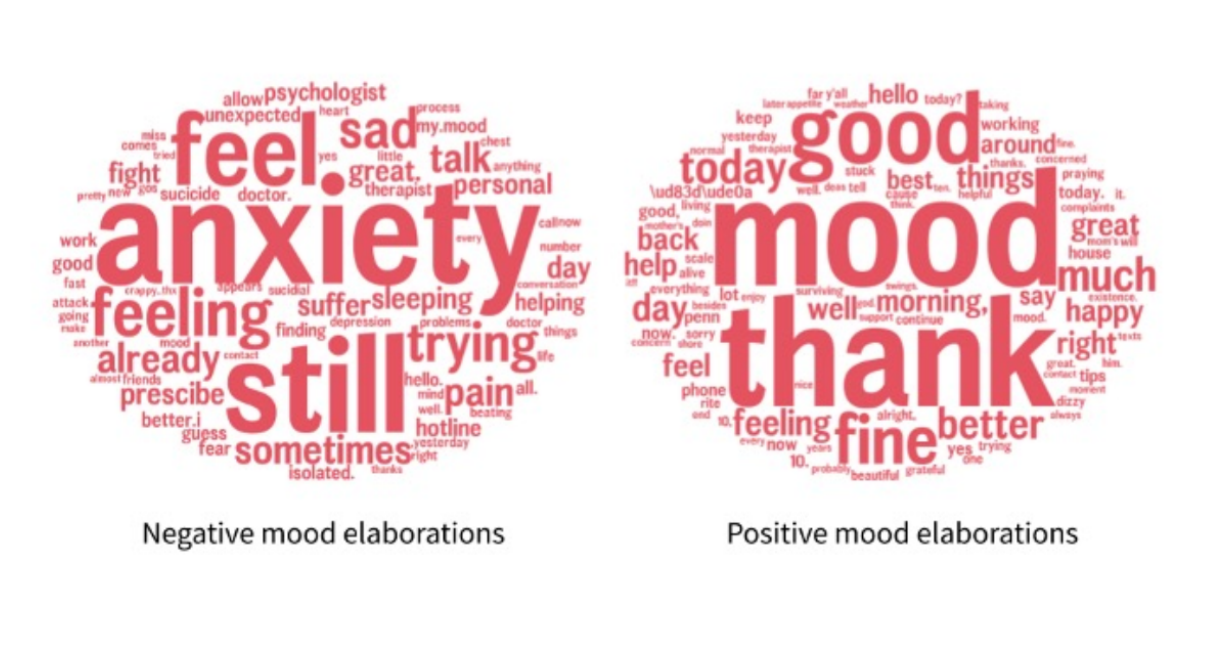
Figure 4. For the respondents who provided qualitative text responses related to mood (n=136), positive mood elaborations were most common (n=71, 52.6%) and frequently referenced sentiments of “good mood” secondary to “thanks.” Negative mood elaborations (n=17, 12.6%) often referencing statements of “anxiety,” “feel,” and